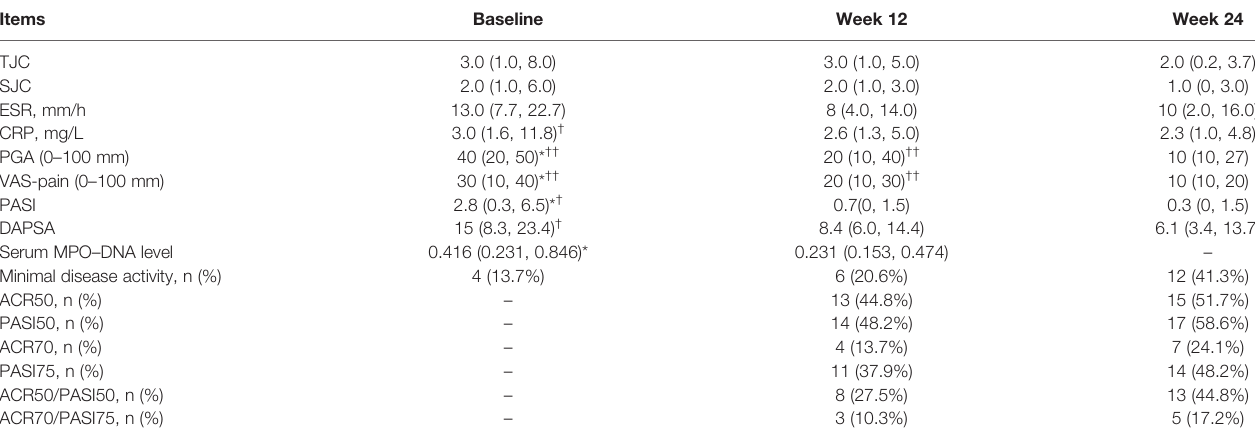
TABLE 4 | Treatment response and changes of serum MPO – DNA of 29 patients with PsA.